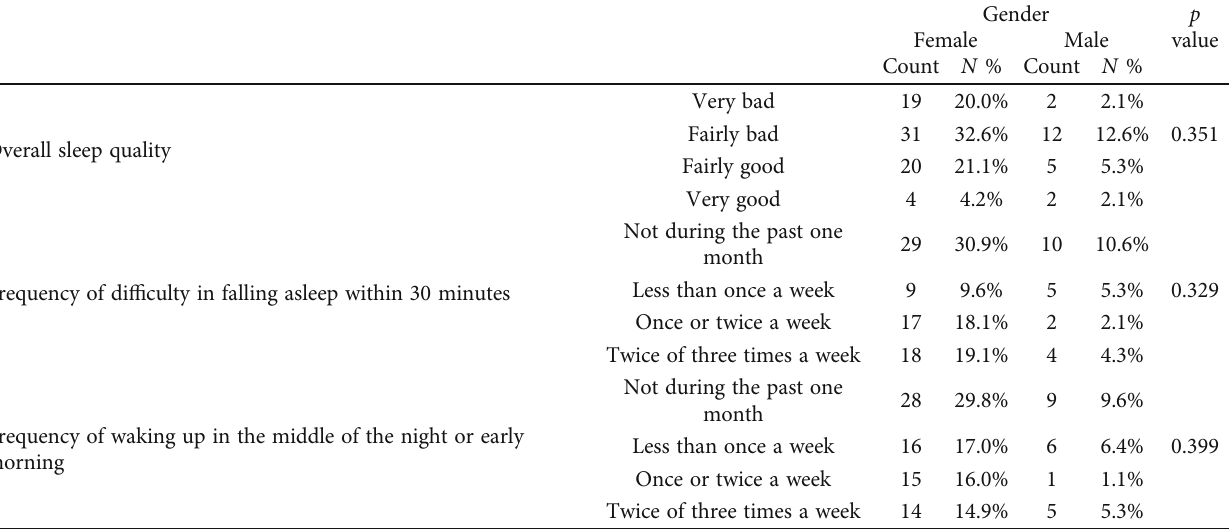
Table 4: Sleep quality amongst participants based on